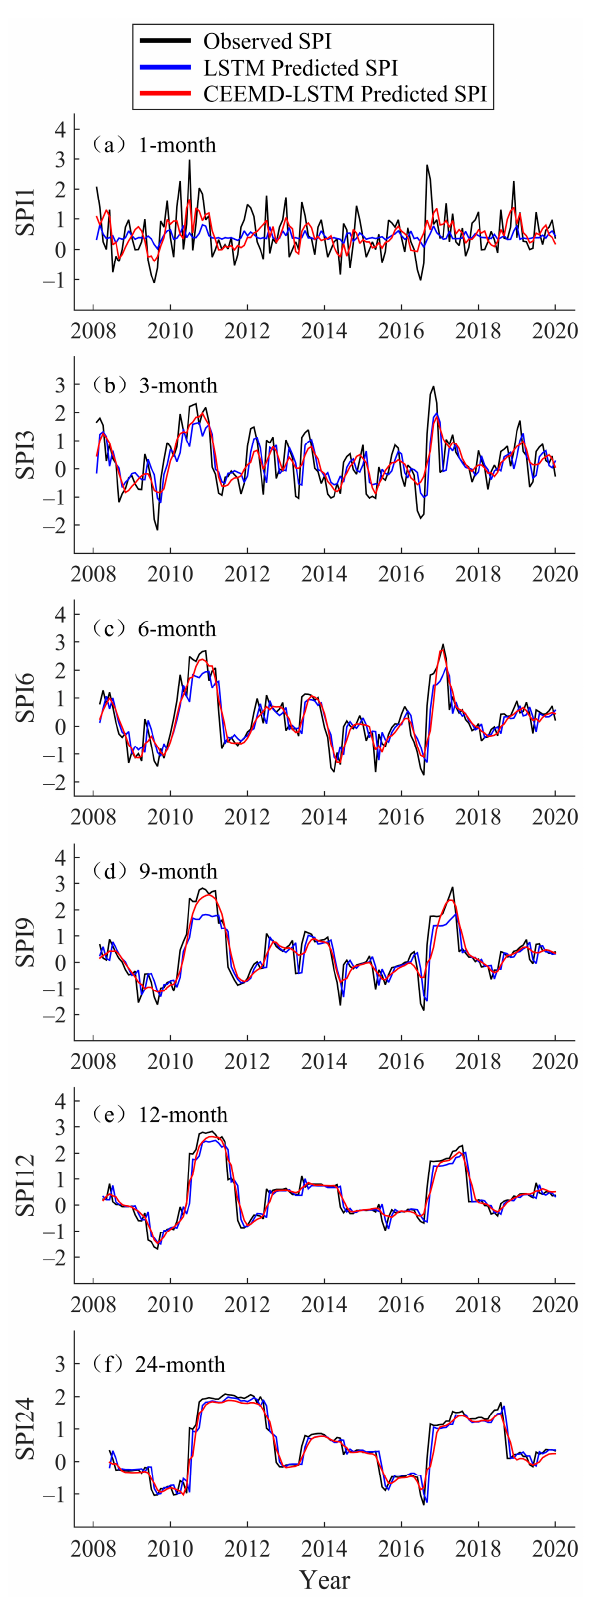
Figure 7. Forecast of multi-timescale SPI values of the LSTM and CEEMD-LSTM model at Yutian Station (2008–2019).